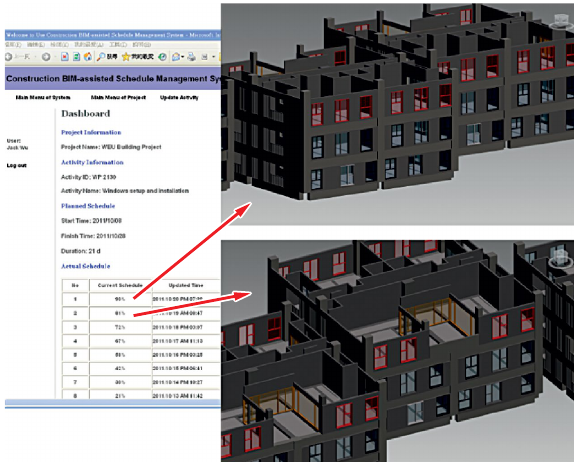
Fig. 4. As-built schedule update information with BIM-assisted visualization in the case